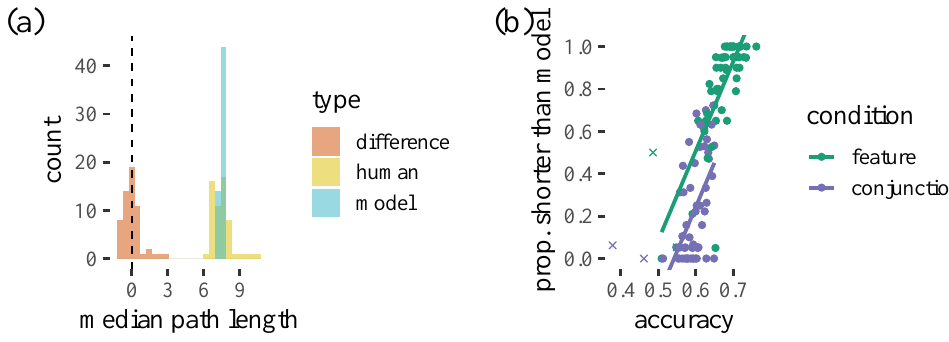
Figure 4. ( a ) Histogram showing the distribution of the median path lengths for our human par- ticipants and model (fitted to each human participant via the random effect structure). ( b ) The relationship between model accuracy and the proportion of trials in which the human participant has a shorter total path length than